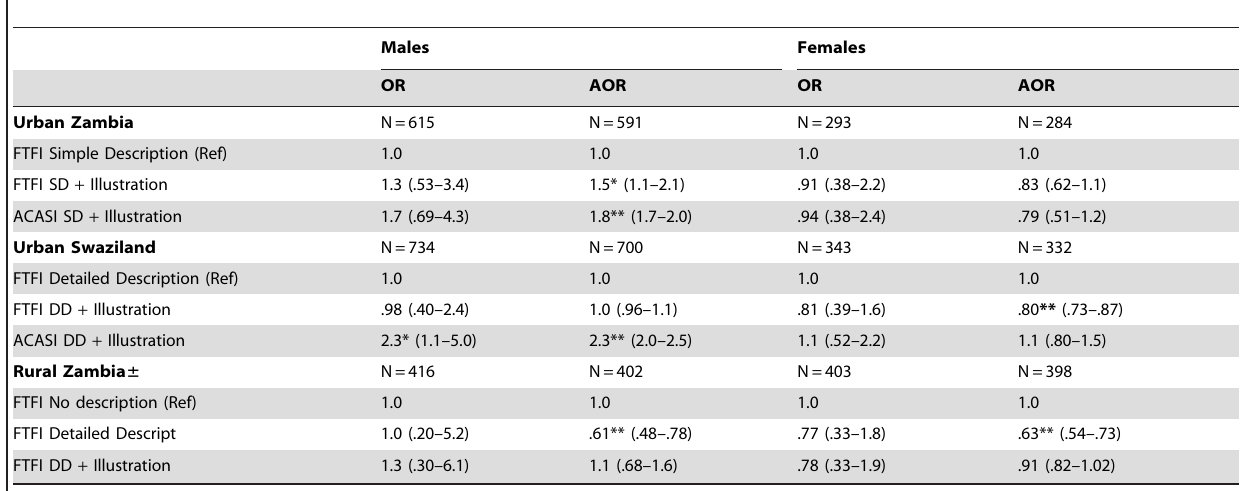
Table 3. Logistic regression assessing experimental arms on misreporting of